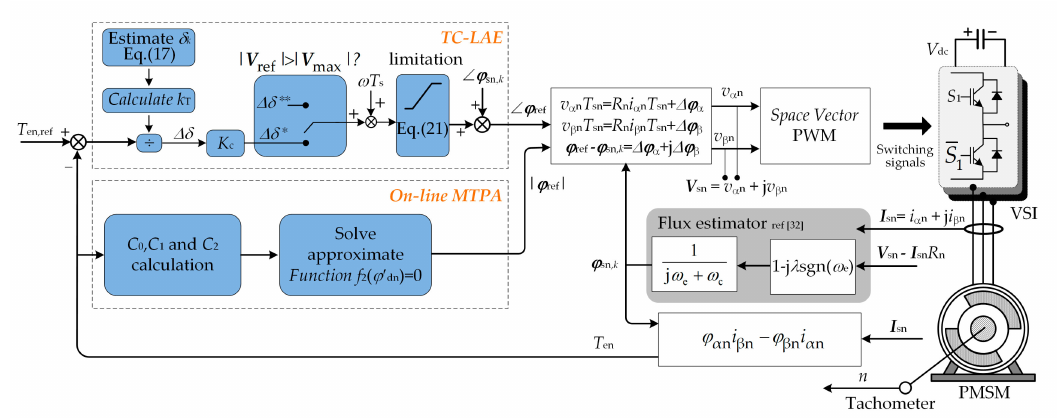
Figure 4. The schematic diagram of the proposed DTC-SVM